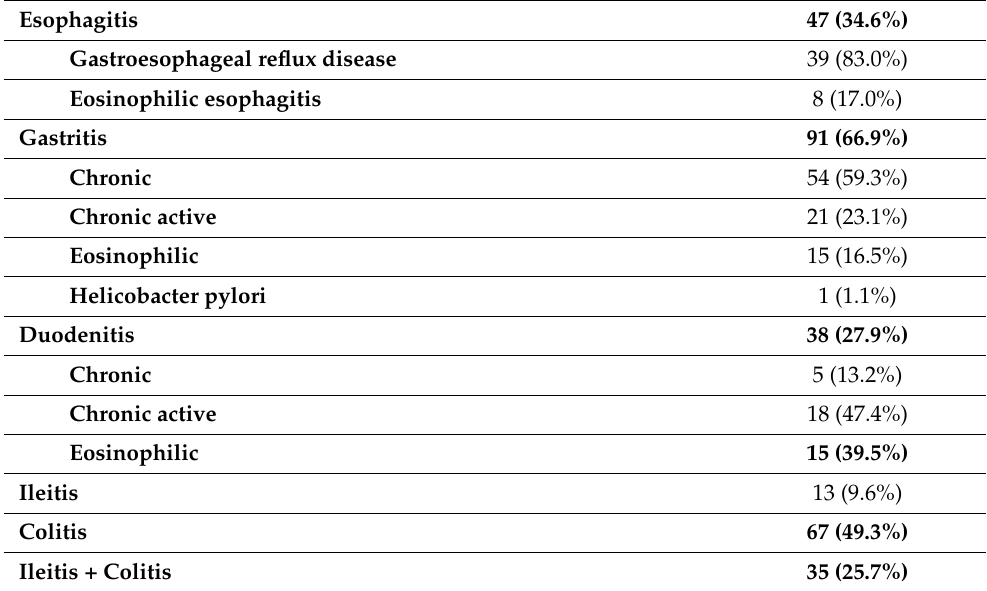
Table 1. Histologic inflammation of the gastrointestinal tract in patients with inflammatory bowel